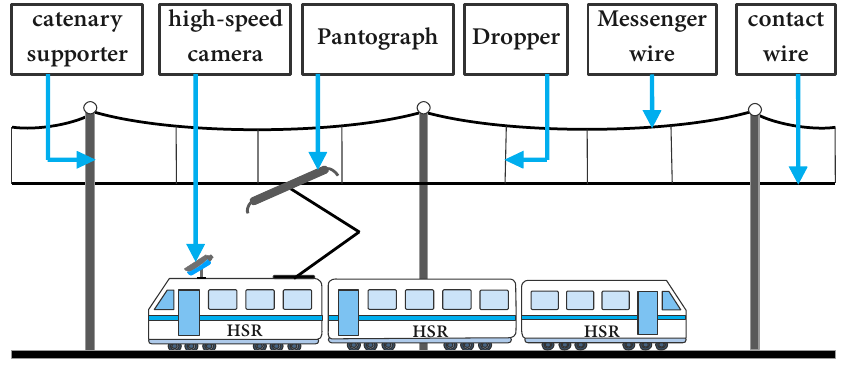
Figure 1. Schematic of PCS.